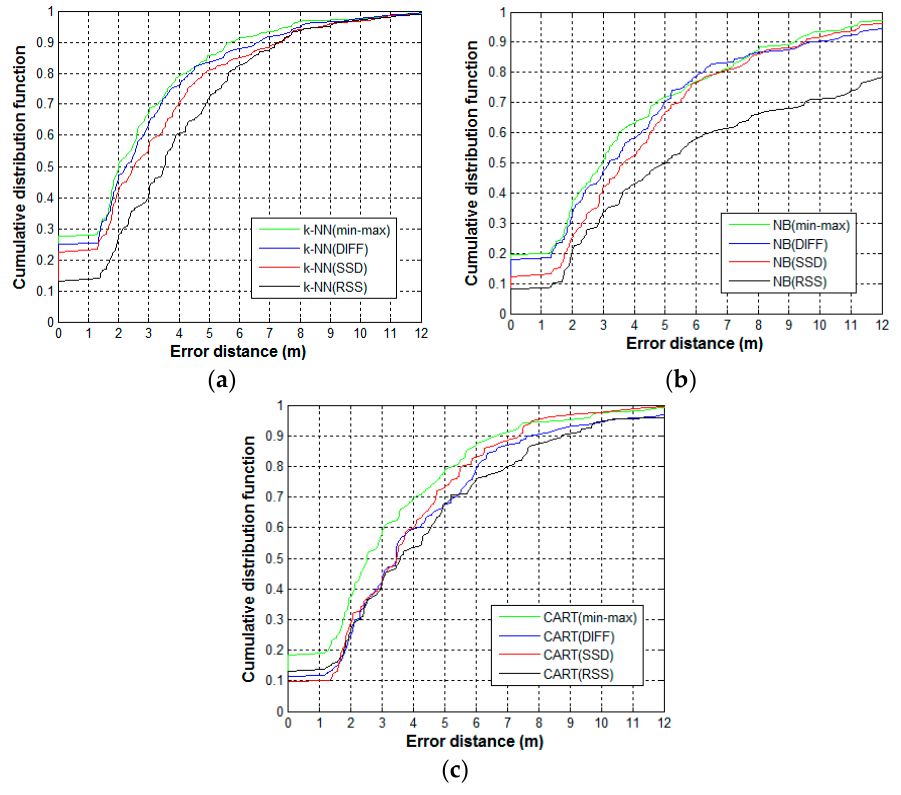
Figure 6. Cumulative distribution function (CDF) plots of error distance for the different preprocessing methods: ( a ) k Nearest Neighbors ( k -NN); ( b ) Naive Bayes (NB); and ( c ) Classification and Regression Trees (CART).